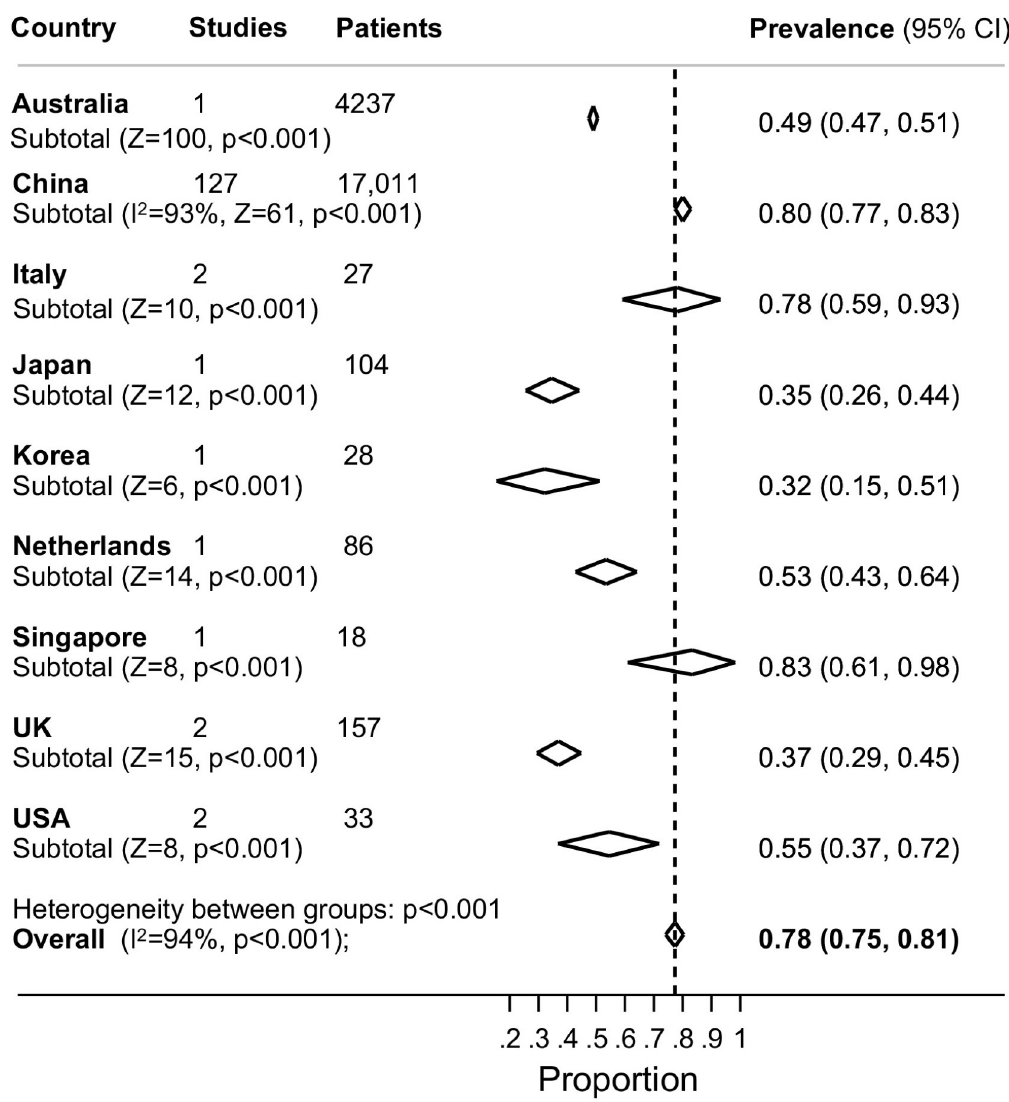
Fig 2. Forest plot of the prevalence of fever in adults with laboratory test confirmed COVID-19. The diamonds are summary estimates from each